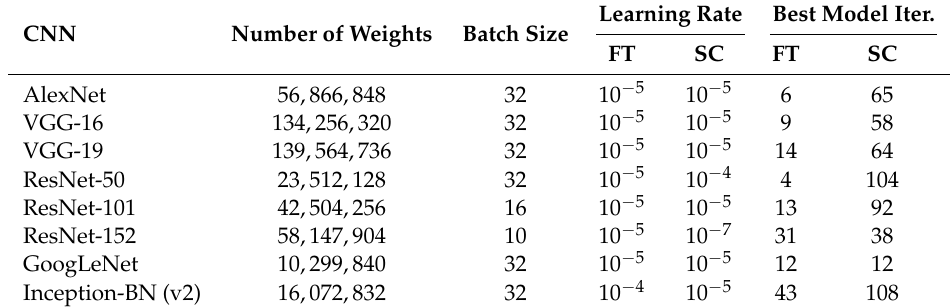
Table 1. Network parameters in the case of fine-tuning (FT) and from-scratch (SC) training scenarios. CNN Number of Weights Batch Size